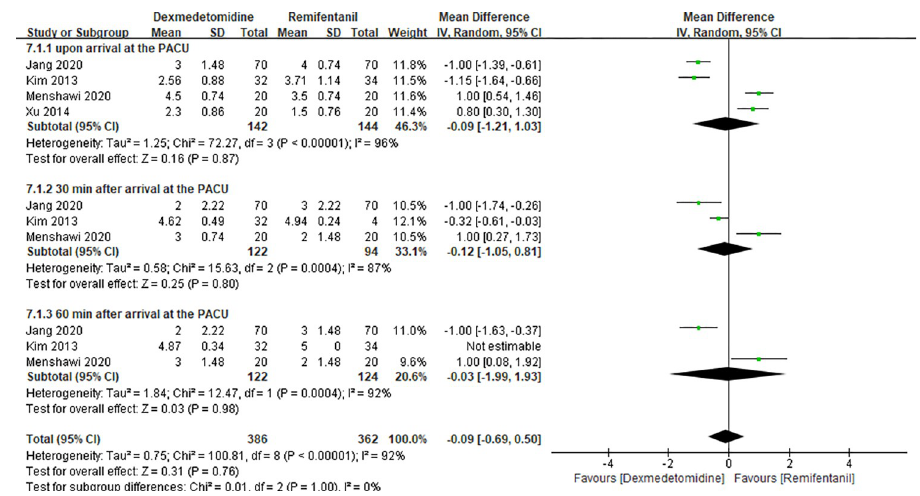
Fig 9. Forest plot of sedation scores at the PACU. Dexmedetomidine group vs. remifentanil group.